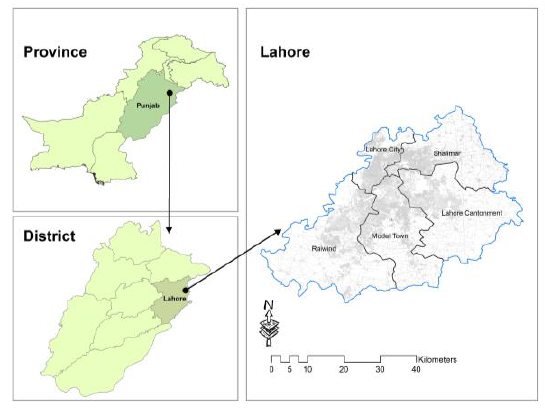
Figure 1 . Location